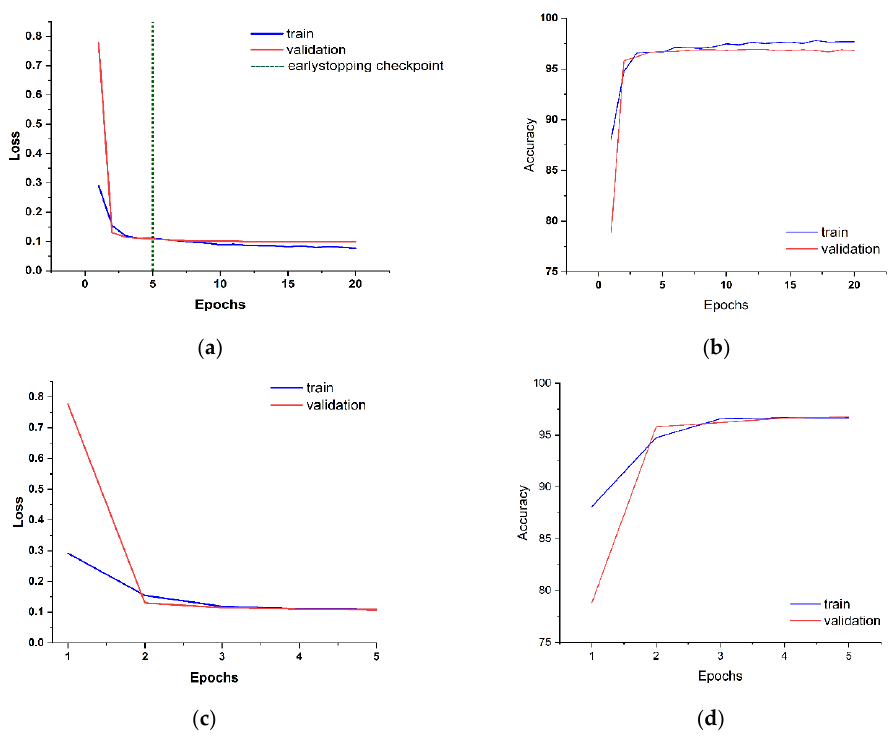
Figure 8. Accuracy and loss curves as a result of applying the proposed model on the Mendeley dataset. ( a ) Train and validation loss (20 epochs) (early stopping applied). ( b ) Train and validation accuracy (20 epochs). ( c ) Training and validation loss. ( d ) Training and validation accuracy. Table 9. Performance comparison of the proposed methodology with other studies .